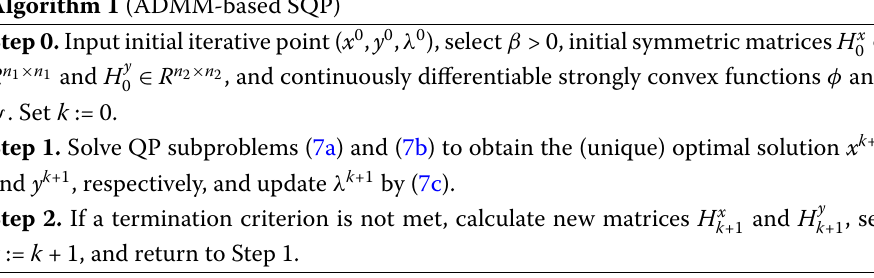
Algorithm 1 (ADMM-based